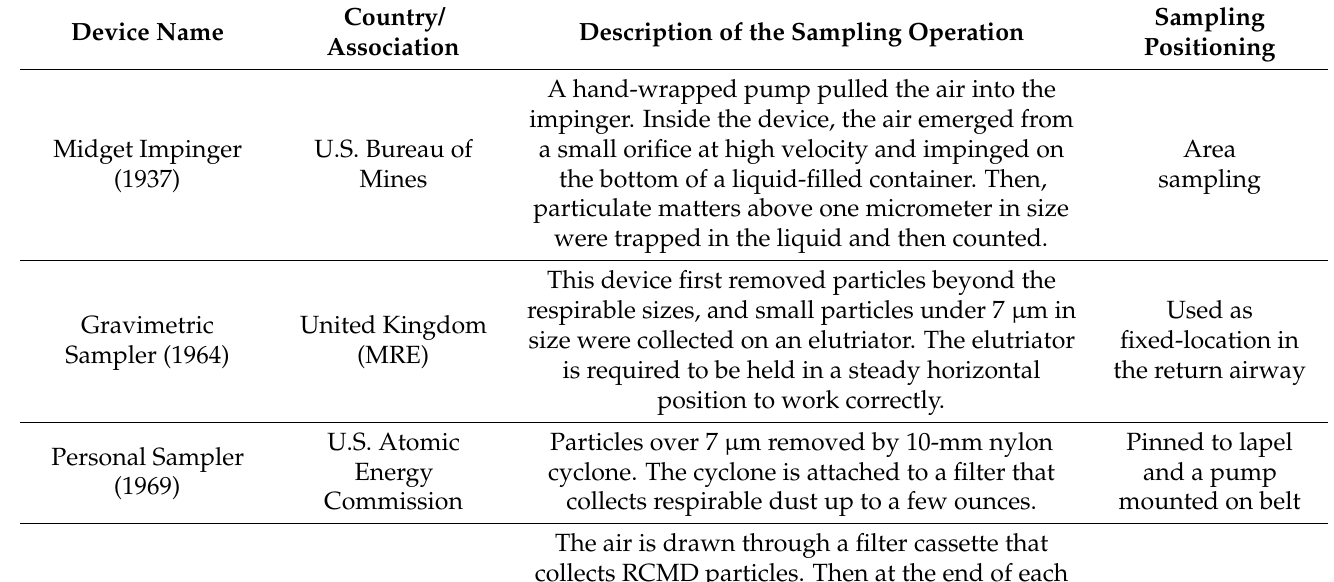
Table 3. Development of permissible dust sampling devices for measuring respirable dust